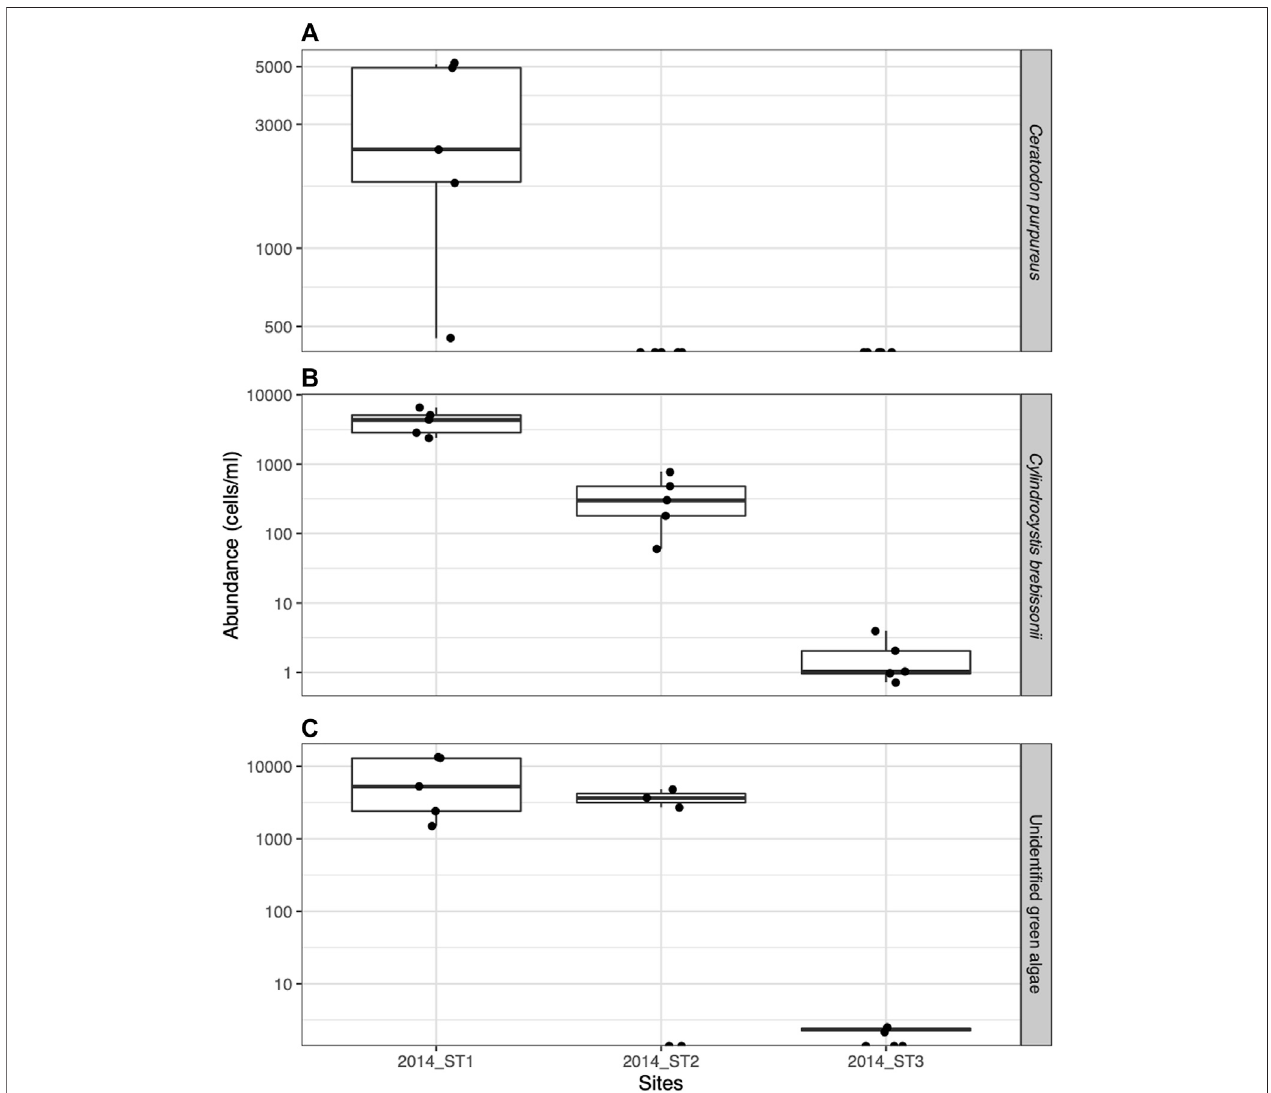
FIGURE6| Spatialvariationofthecellconcentration(cellcount/ml)ofphototrophsonStanleyGlacier: (A) Celatodonpurpureus, (B) Cylindrocystisbrebissonii, and (C) unidenti fi ed green algae).